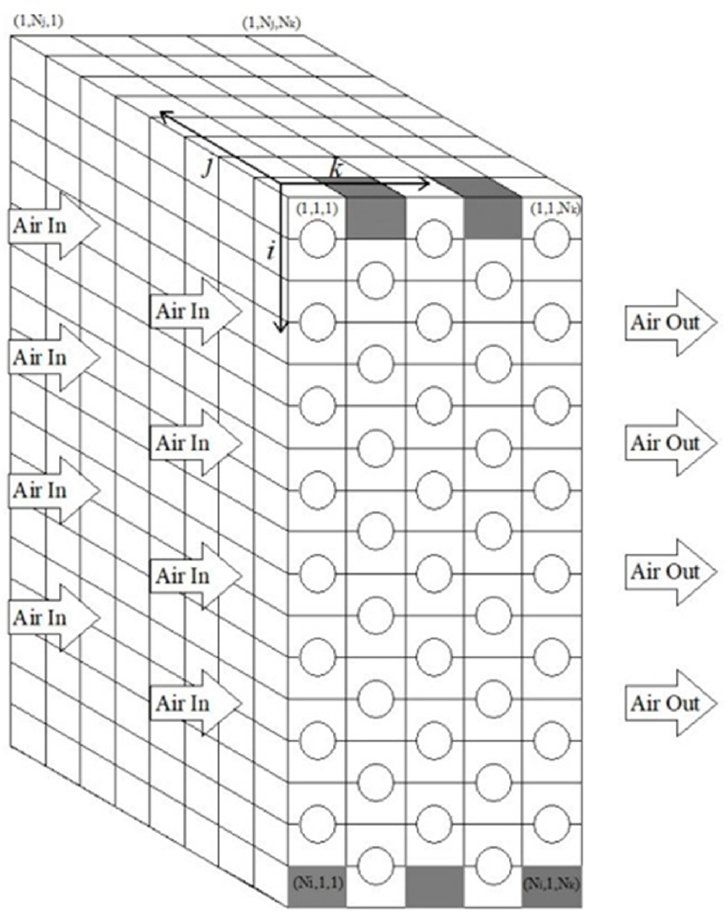
Figure 18. The scheme of the HX’s geometry through a three-dimensional matrix [88].